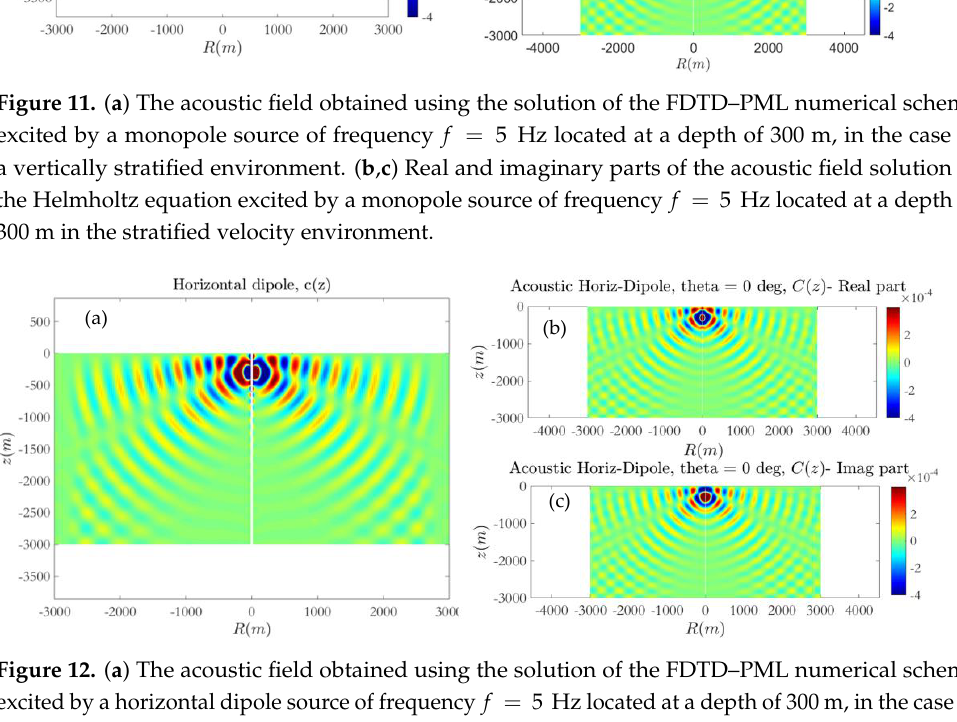
excited by a horizontal dipole source of frequency 5 f Hz = located at a depth of 300 m, in the case of a vertically stratified environment. ( b , c ) Real and imaginary parts of the acoustic field ob-